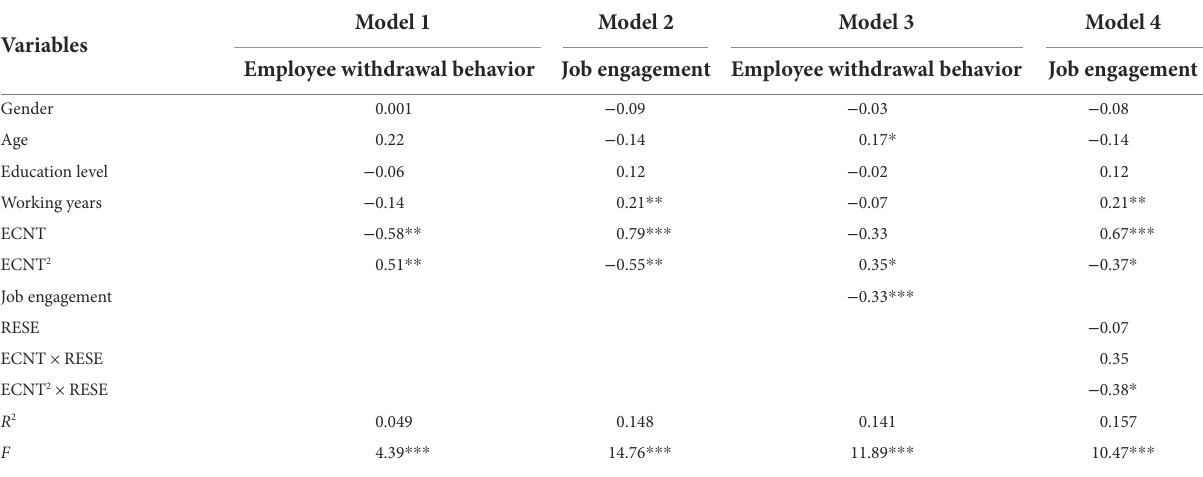
TABLE 3 The results of hierarchical regression